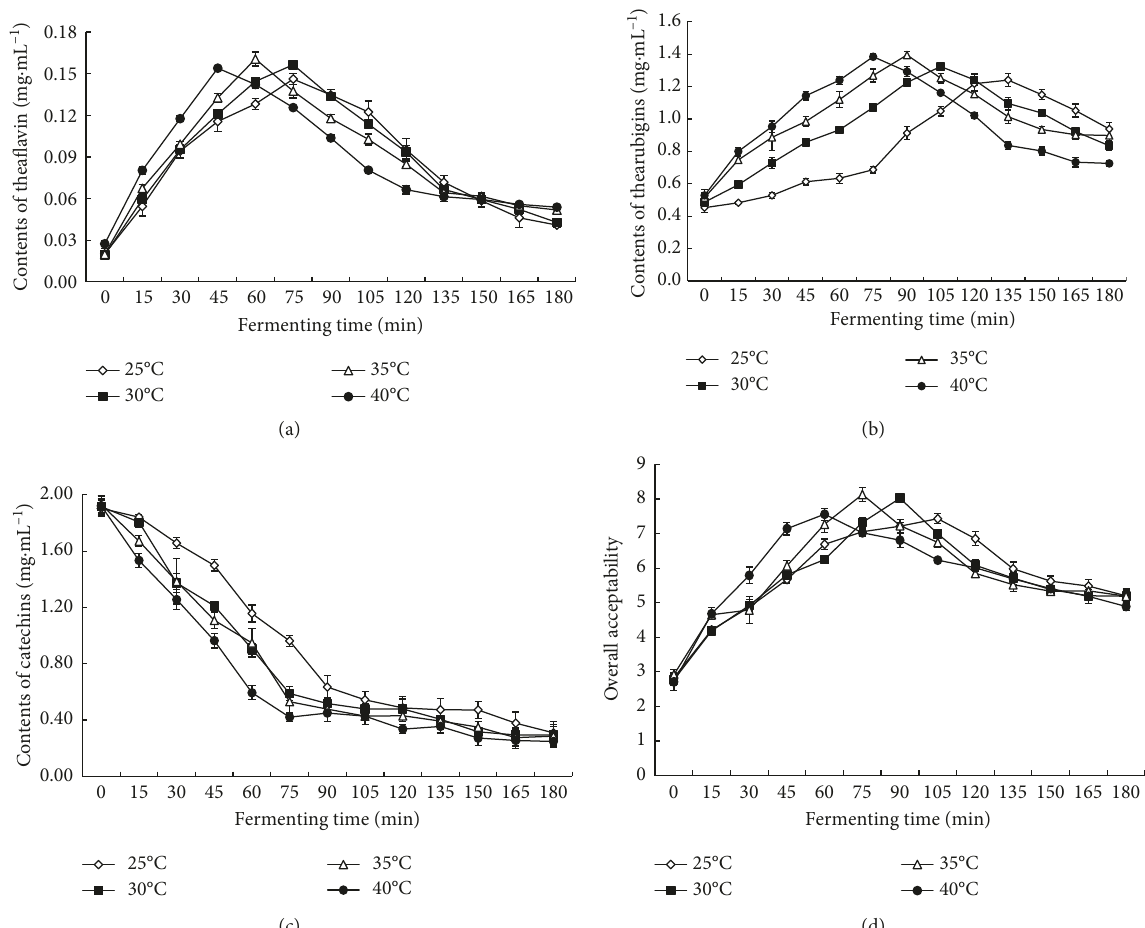
Figure 1: Effect of fermentation time and temperature on the concentrations of (a) theaflavins, (b) thearubigins, (c) catechins, and (d) the overall acceptability of fermented juices ( n �